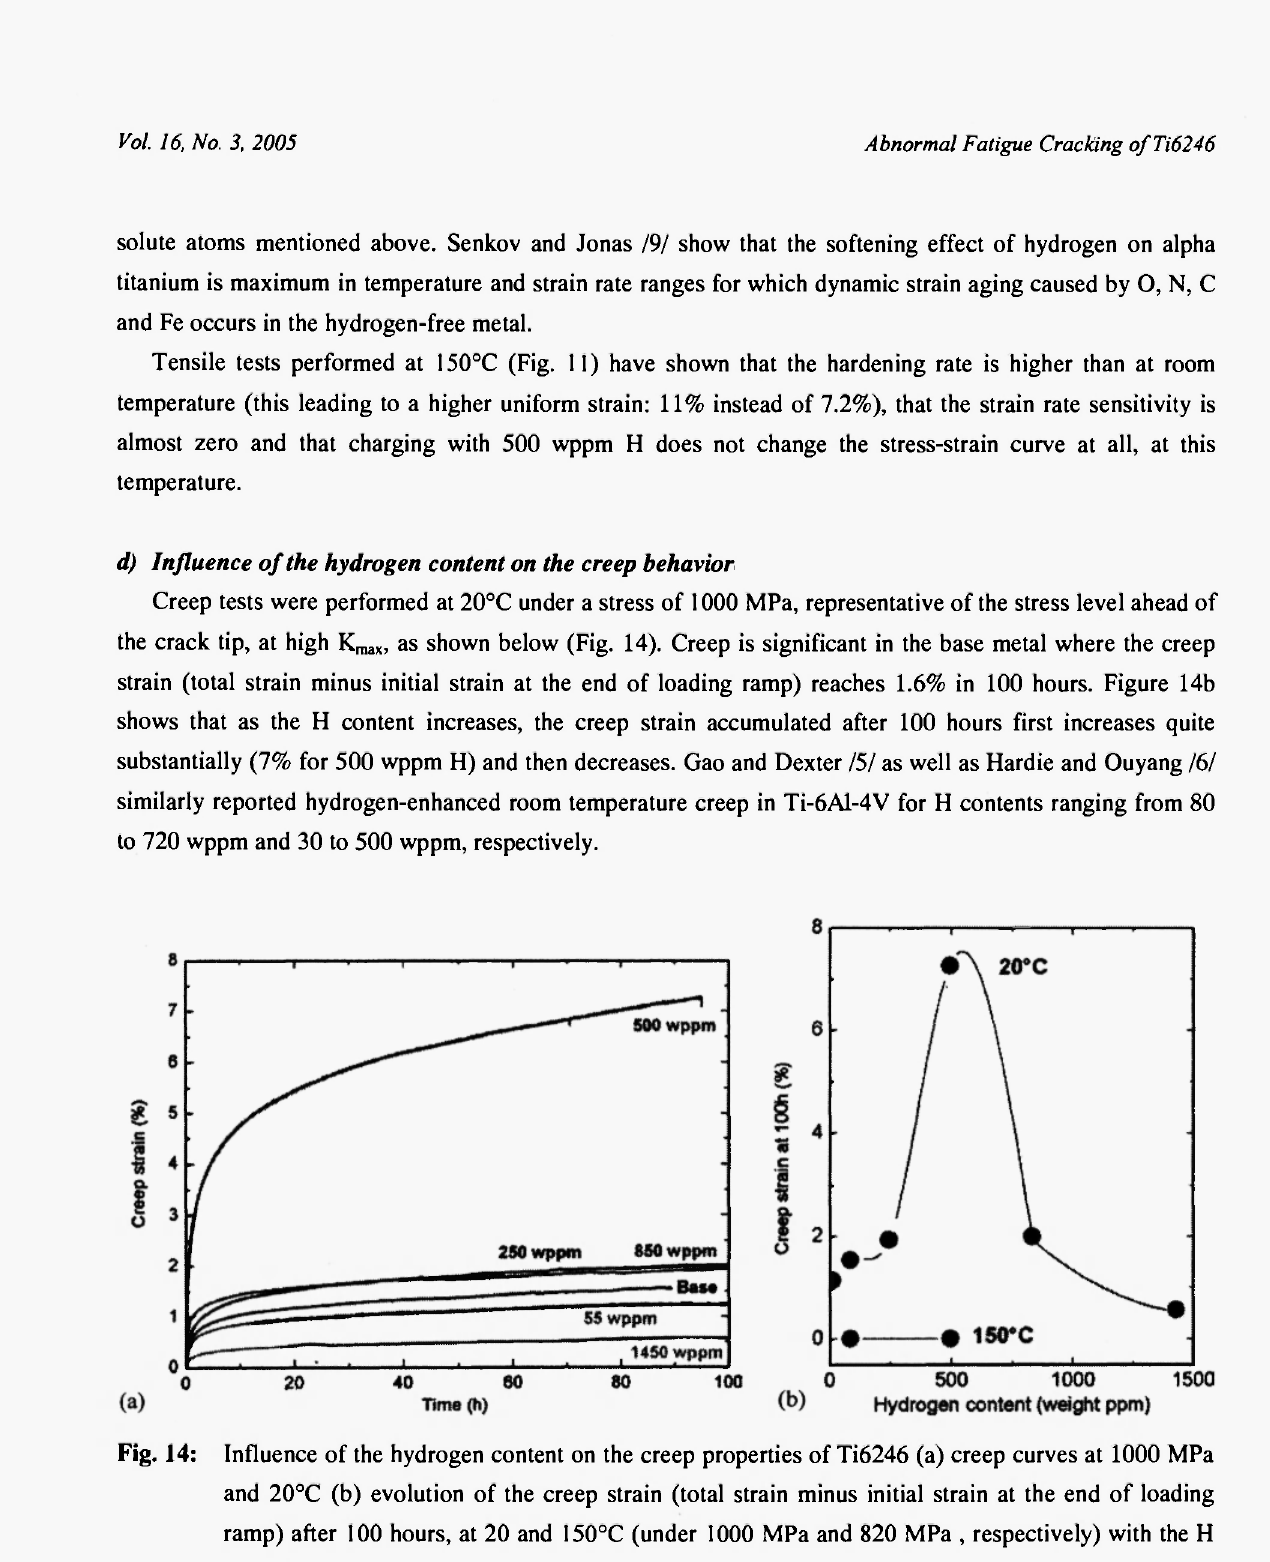
Fig. 14: Influence of the hydrogen content on the creep properties of Ti6246 (a) creep curves at 1000 MPa and 20°C (b) evolution of the creep strain (total strain minus initial strain at the end of loading ramp) after 100 hours, at 20 and 150°C (under 1000 MPa and 820 MPa , respectively) with the Η